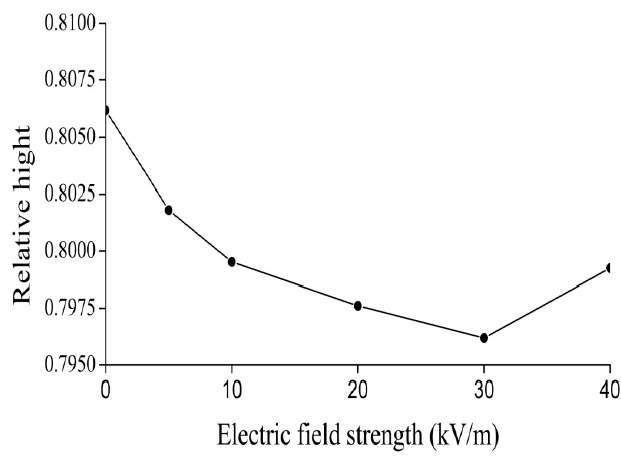
Figure 12. Changes in the relative height of a 1650-cm − 1 peak with increases to externally applied voltage.